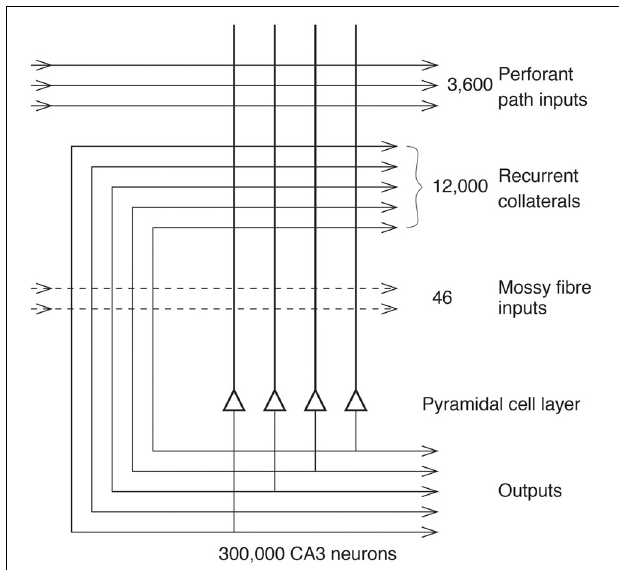
FIGURE 2 | The numbers of connections from three different sources onto each CA3 cell from three different sources in the rat. (After Treves and Rolls, 1992; Rolls and Treves,